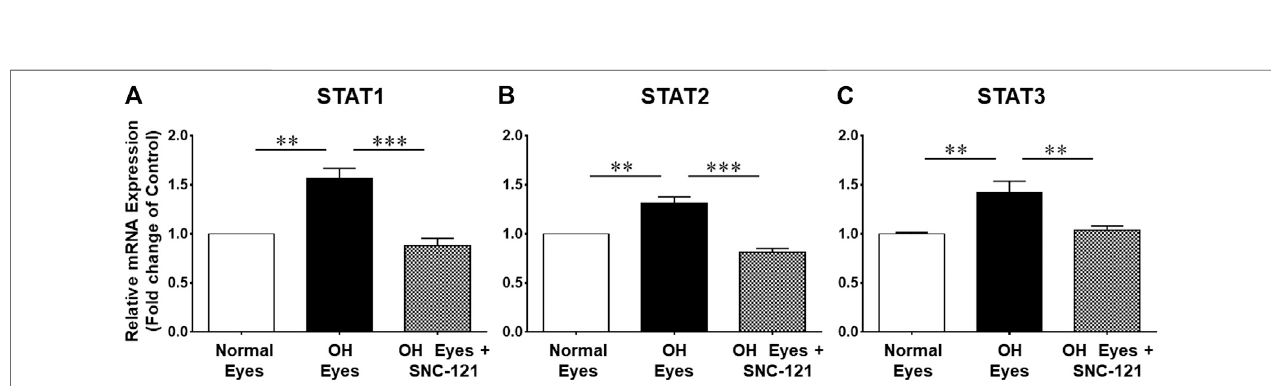
FIGURE 3 | Effects of SNC-121 treatment on mRNA expression of STAT1 (A) , STAT2 (B) , and STAT3 (C) . The retina from normal, ocular hypertensive, and SNC- 121 treated ocular hypertensive animals were collected at day 7, post hypertonic saline injection. Complementary DNA was synthesized from 1 µg total RNA extracted from retina. The relative changes in mRNA levels were measured by quantitative RT-PCR (qRT-PCR) using primers speci fi c for each gene as indicated in Table 1 . The qRT-PCR data was normalized using ß -actin gene expression as an internal control. The relative expression was calculated based on the comparative threshold cycle (2 − ΔΔ Ct ) method. Bar graph represents mean data ± SEM. OH Eyes; ocular hypertensive eyes; OH Eyes + SNC-121, ocular hypertensive eyes with SNC-121 treatment. ** p < 0.01; *** p < 0.001; n (cid:2) 4 – 9. In this experiment “ n ” represent a biological replicate.